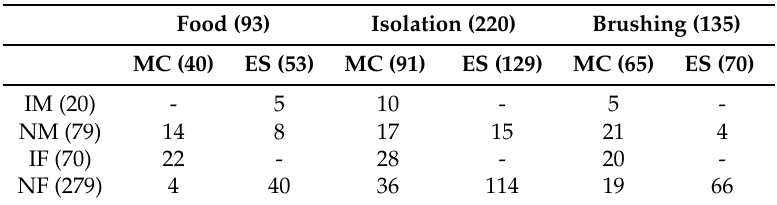
Table 1. Dataset composition (MC, Maine Coon; ES, European Shorthair; IM/IF, Intact Males/Females; NM/NF, Neutered